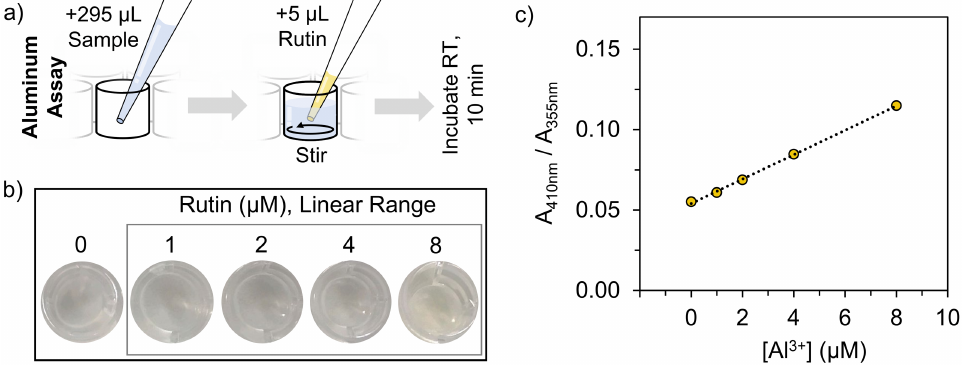
Figure 2 Rutin-based colorimetric assay overview of aluminum quantification. Overview of the rutin- based colorimetric assay for Al 3 + ion quantification. (A) Representation of the assay procedure. (B) Visual representation of assay samples containing aluminum concentrations within the linear range of quantifi- cation. (C) Calibration curve of the assay reported as the ratio of the absorbance at 410 and 355 nm ver- sus aluminum concentration. The values in panel (C) are the average of n = 3 measurements whereas the error bars, which are small and within the boundaries of the marker, are the standard deviation of n = 3 measurements. Full-size DOI: